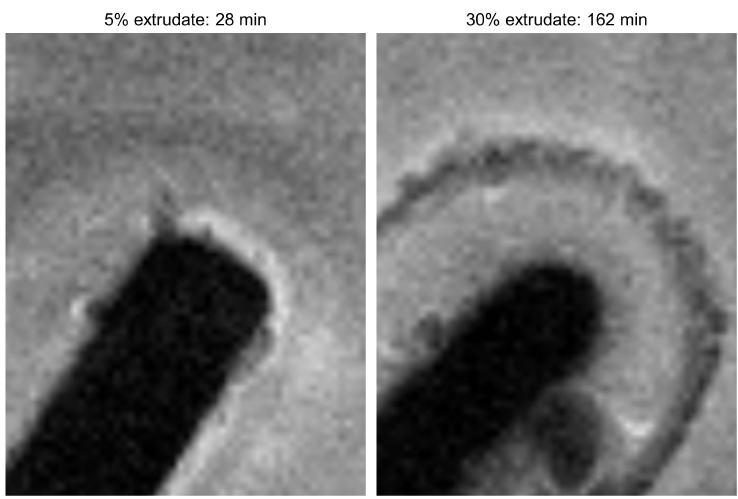
Figure 7. Zoom of the images collected for the 5% extrudate (28 min) and 30% extrudate (162 min) to highlight the well-defined region of intermediate MRI contrast present in the 30%